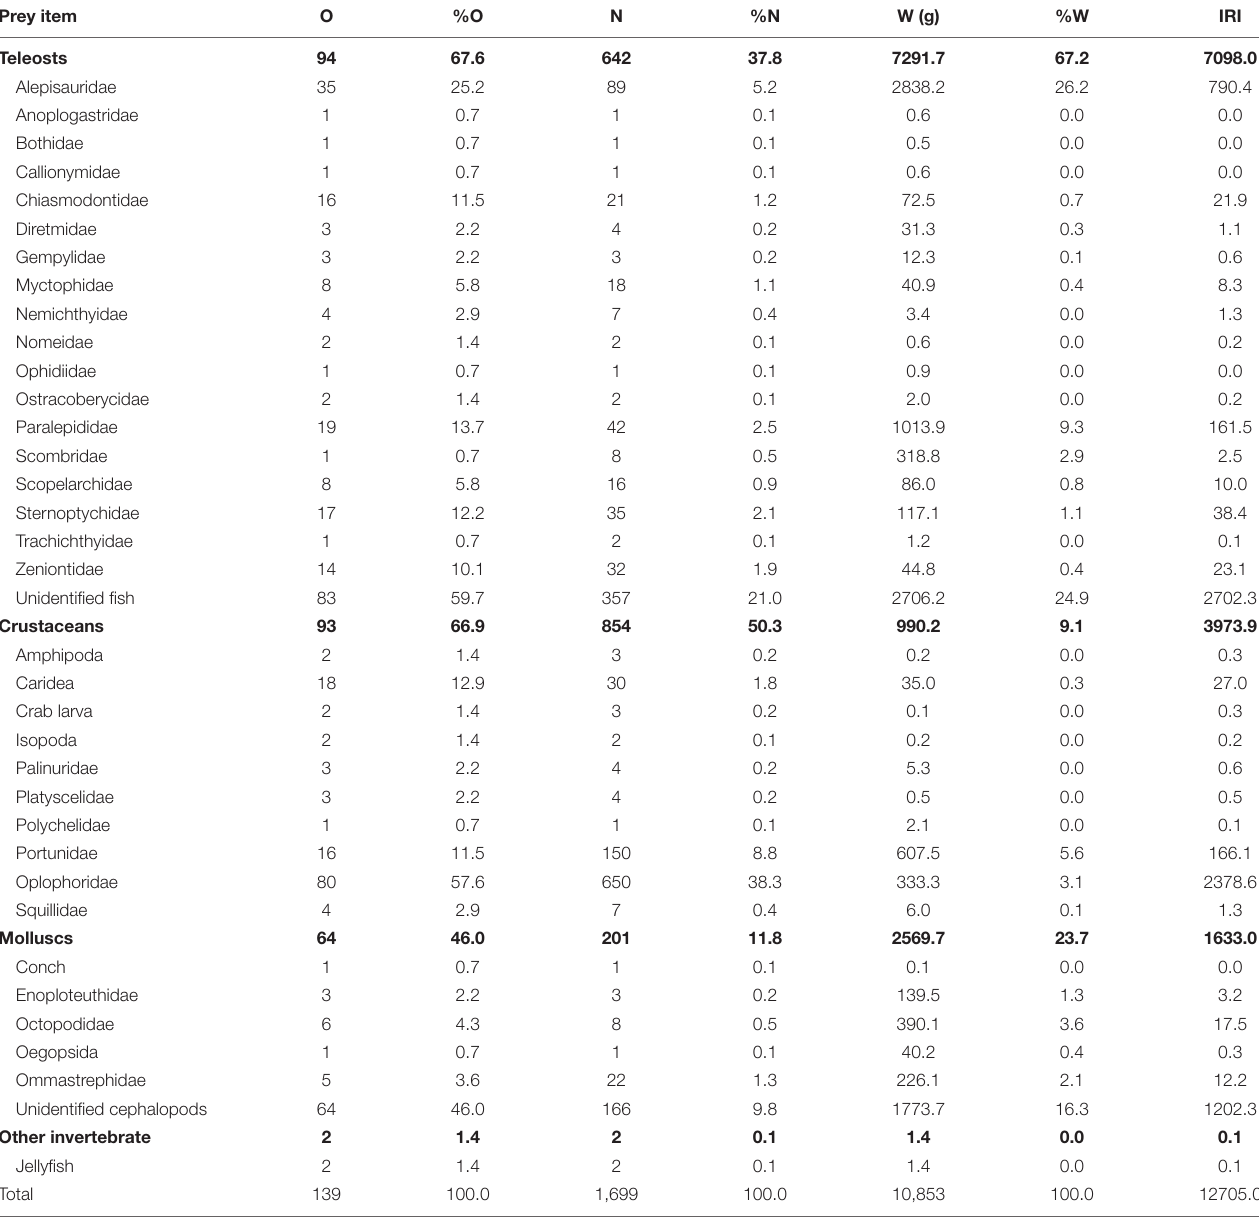
TABLE 1 | Number of stomachs containing the prey item (O), percentage of occurrence (%O), number of prey items (N), numerical percentage (%N), weight of prey items (W), weight percentage (%W), and index of relative importance (IRI) of bigeye tuna Thunnus obesus . Prey